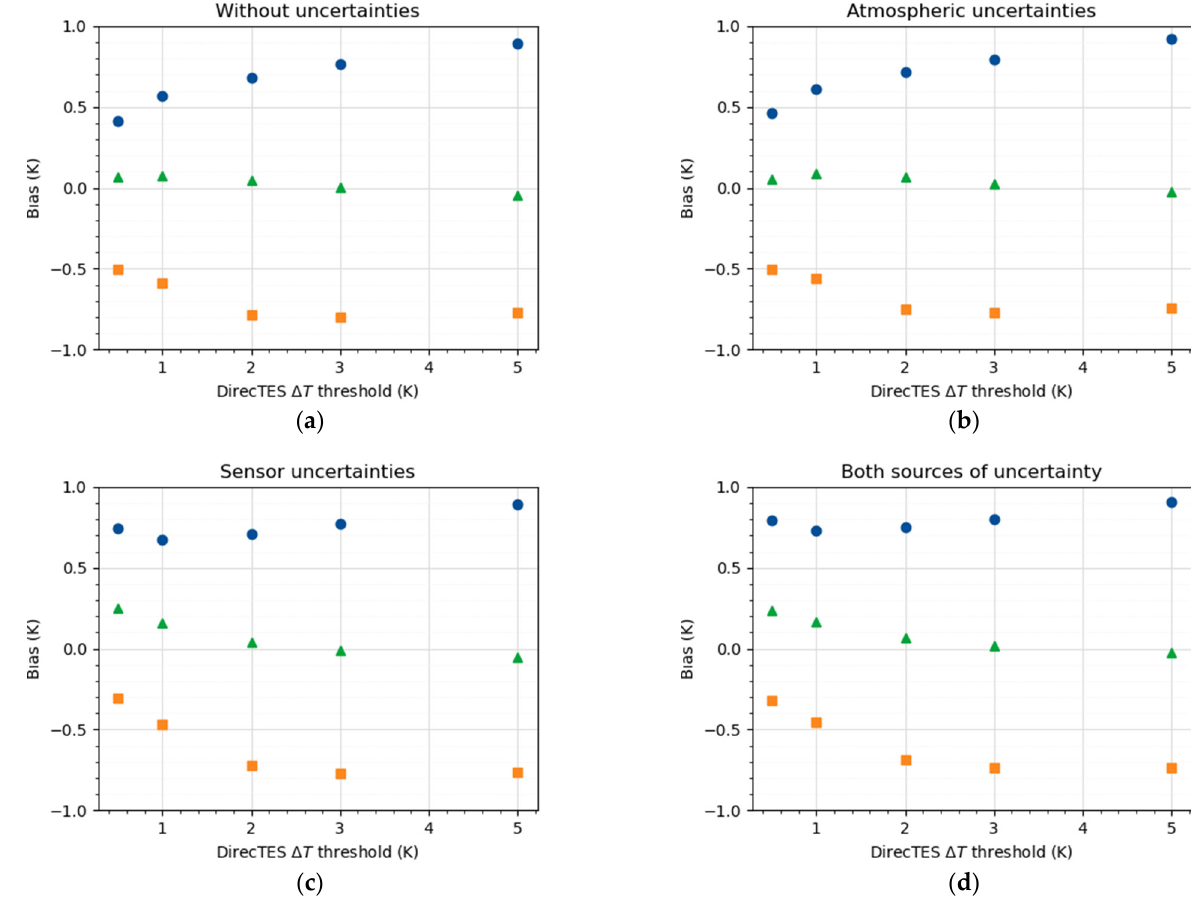
Figure 9. Bias in DirecTES retrieved temperature as a function of DirecTES ∆ T threshold ( ∆ T thresh ) , for each kind of material (green triangle: vegetation; blue dot: water; orange square: urban materials) in the presence of no uncertainty ( a ), atmospheric ( b ), sensor ( c ) and both sources of uncertainty ( d ).